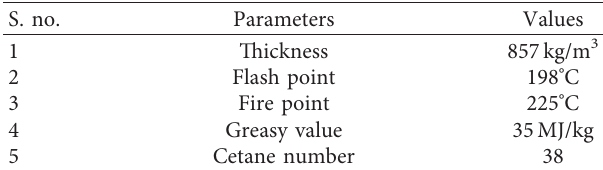
Figure 1: Step-by-step process of investigation process. Table 1: Properties of cotton seed